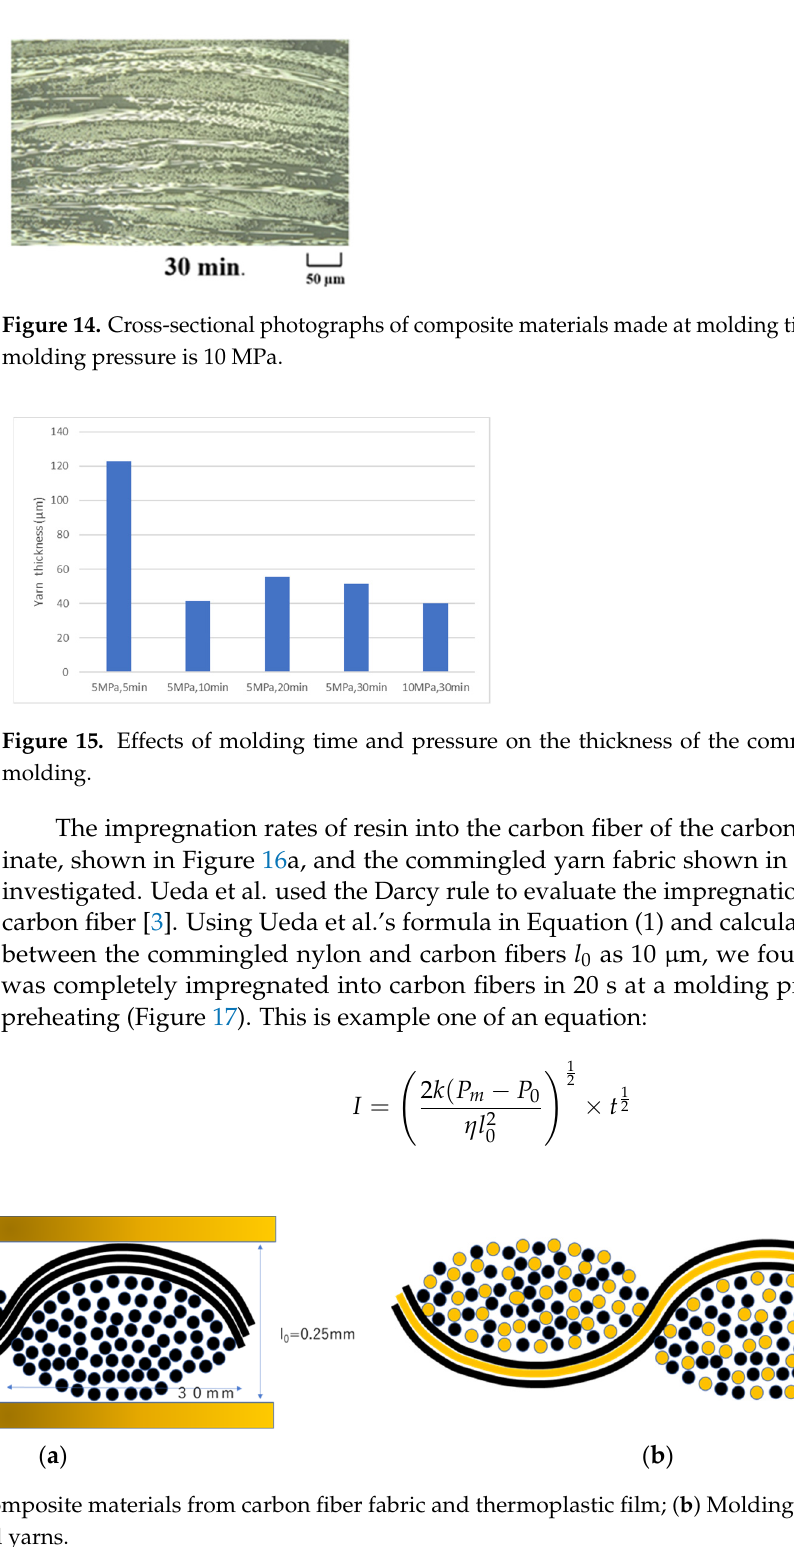
Figure 16. ( a )Molding of composite materials from carbon fiber fabric and thermoplastic film; ( b ) Molding of composite materials from commingled yarns.